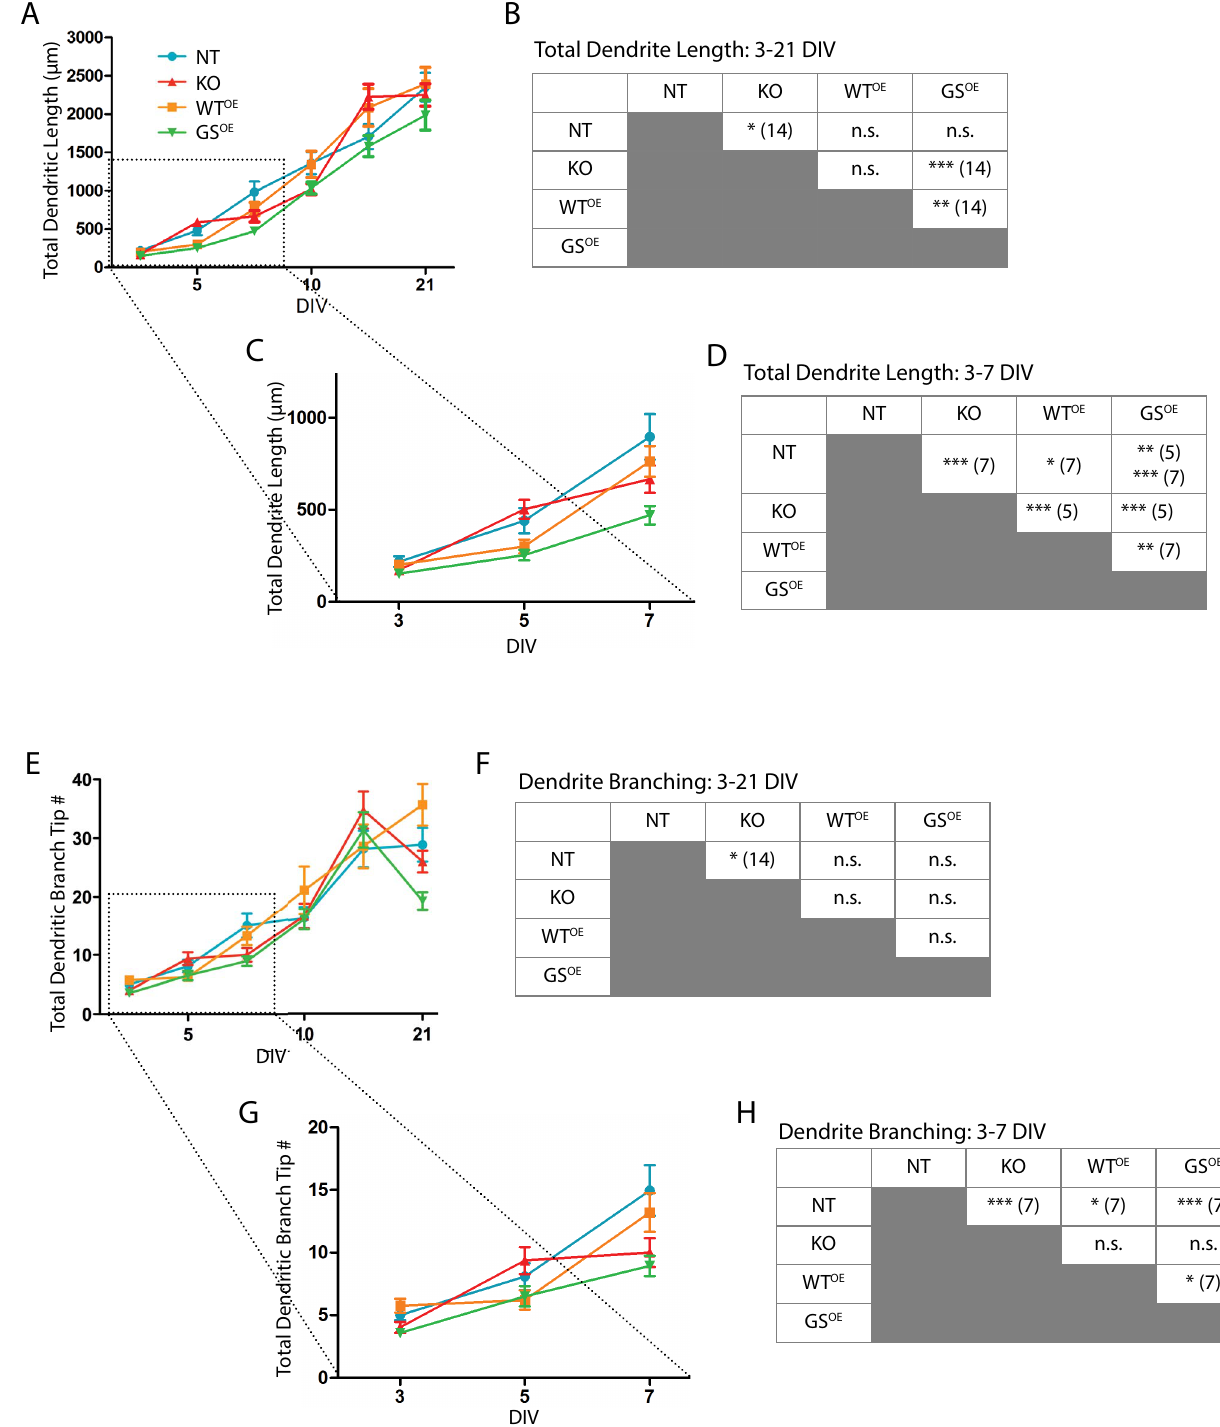
Figure 3. LRRK2-G2019S OE negatively regulates dendritic growth and branching. Line graph (A) plots total dendritic length per neuron over time for neurons of all four genotypes. Data are shown as mean 6 SEM. Table (B) shows results of Bonferroni’s post-tests, indicating the sources of significant differences identified in a two-way ANOVA (see text). *p , 0.05; **p , 0.01; ***p , 0.001, n.s. = not significant. Numbers in parentheses refer to DIV. Line graph (C) is an expanded view of results from the first week of development shown in (A), and the table (D) shows the post hoc analyses from this subset. Line graph (E) plots the total number of dendritic branch points for all genotypes and the table (F) shows the results of Bonferroni’s post-tests. The line graph (G) is an expanded view of the data shown in (E) and the table (H) shows the post hoc analyses from the first week of development. At least 10 neurons from at least two culture preparations each (at least 20 neurons total) were traced and measured per genotype per time point assessed.